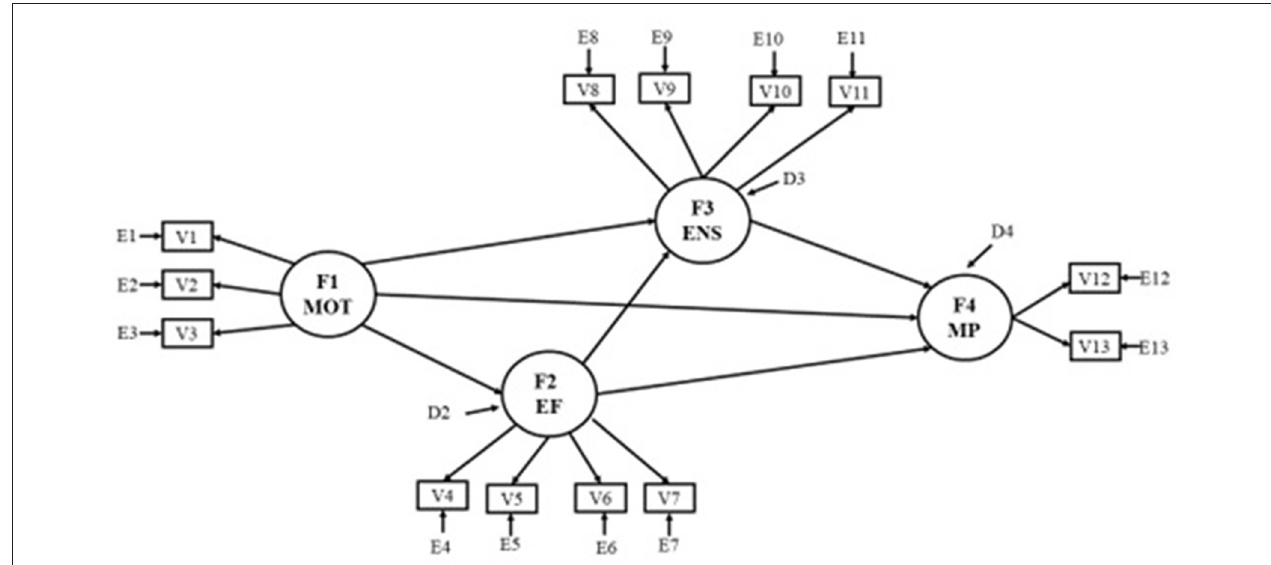
FIGURE 1 | Hypothesized model. F1 MOT, Motivation; F2 EF, Executive Functioning; F3 ENS, Early Numeracy Skills; F4 MP, Mathematical Performance; V1, Competence-motivation; V2, Attention-persistence; V3, Positive internality; V4, Inhibition-Sun/Moon Stroop; V5, Inhibition-Tapping Task; V6, Working memory-Digit Span Backward; V7, Working memory-Counting Task; V8, Procedural counting; V9, Conceptual counting; V10, Logical operations; V11, Symbolic comparison; V12, Informal skills; V13, Formal skills.